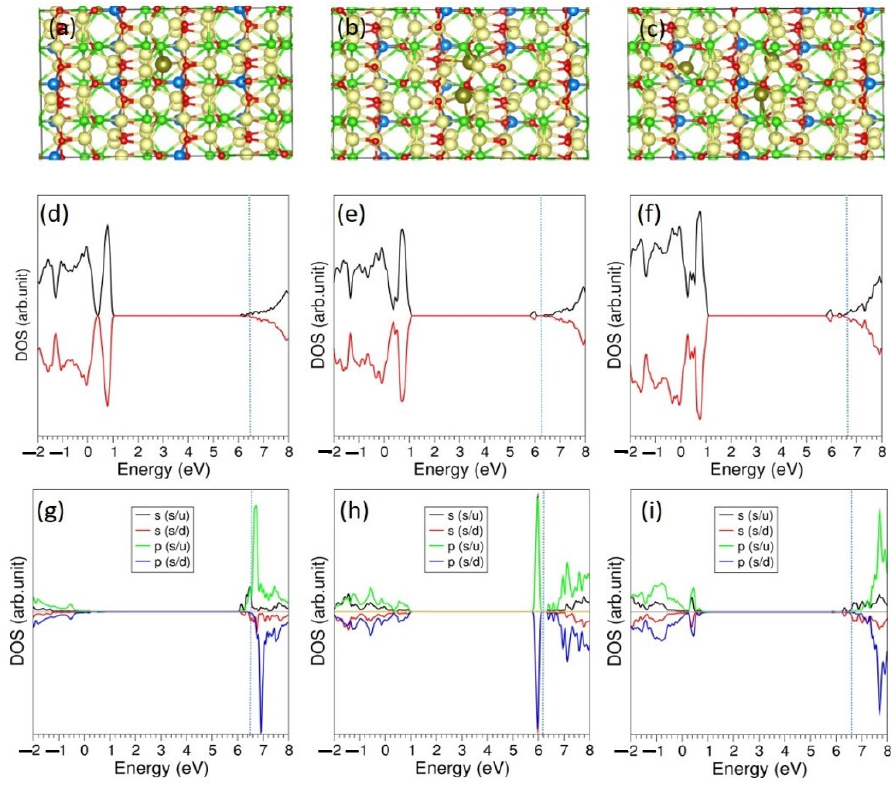
Figure 10. DFT-optimized structures of ( a ) a single Li, ( b ) two Li and ( c ) 3 Li incorporated in Li 6 SiO 4 Cl 2. Total DOS plots ( d – f ), and atomic plots of Li ( g – i ), are also shown. Table 5. Incorporation energies, Bader charges on the Li atoms incorporated and change in volume upon successive